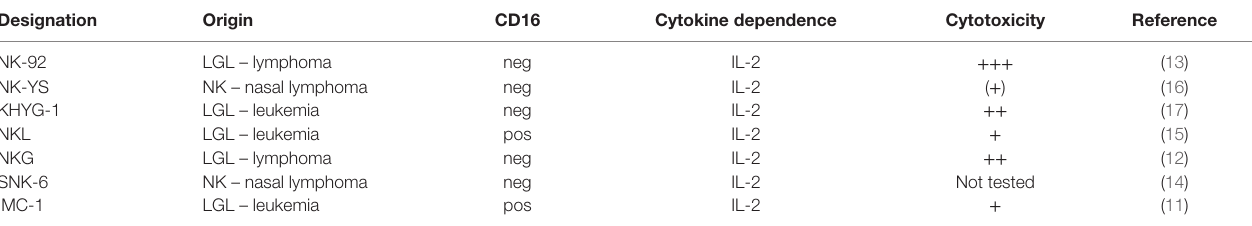
TABLe 1 | NK-cell lines derived from patients with NK-cell